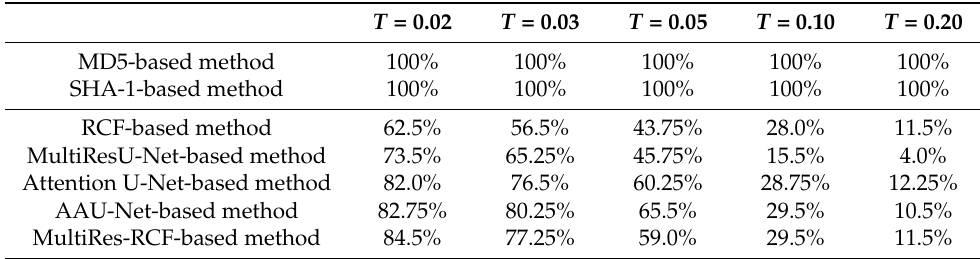
Table 9. Tampering sensitivity comparison of subject-unrelated tampering with 400 RS